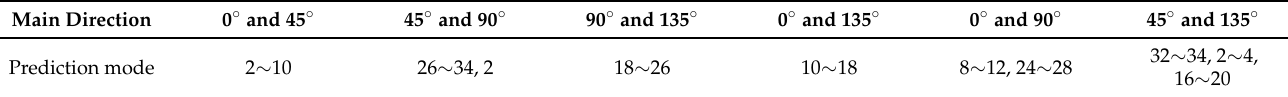
Table 3. Candidate modes for two main directions.